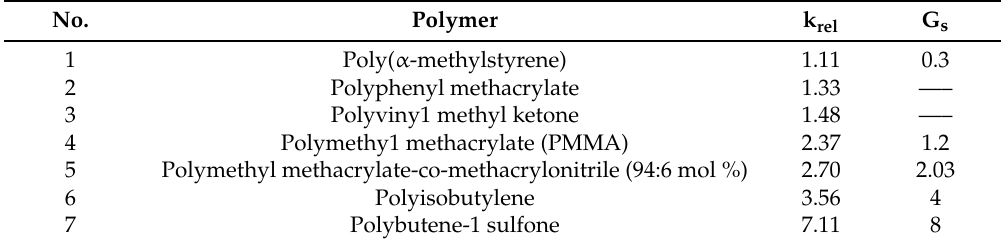
Figure 5. Atomic force microscopy (AFM) images of two small pieces of graphene (top: a monolayer (1 L) graphene strip; bottom: a few-layer graphene strip). ( a ) Before and ( b ) after selective hydrogen plasma edge etching for 60 min at 300 ˝ C (Reproduced with permission from [76]. Copyright American Chemical Society, 2010). Table 2. Relative rates of O 2 plasma removal (k rel ) and G s -values for selected polymers (Reproduced with permission from [72]. Copyright John Wiley and Sons,